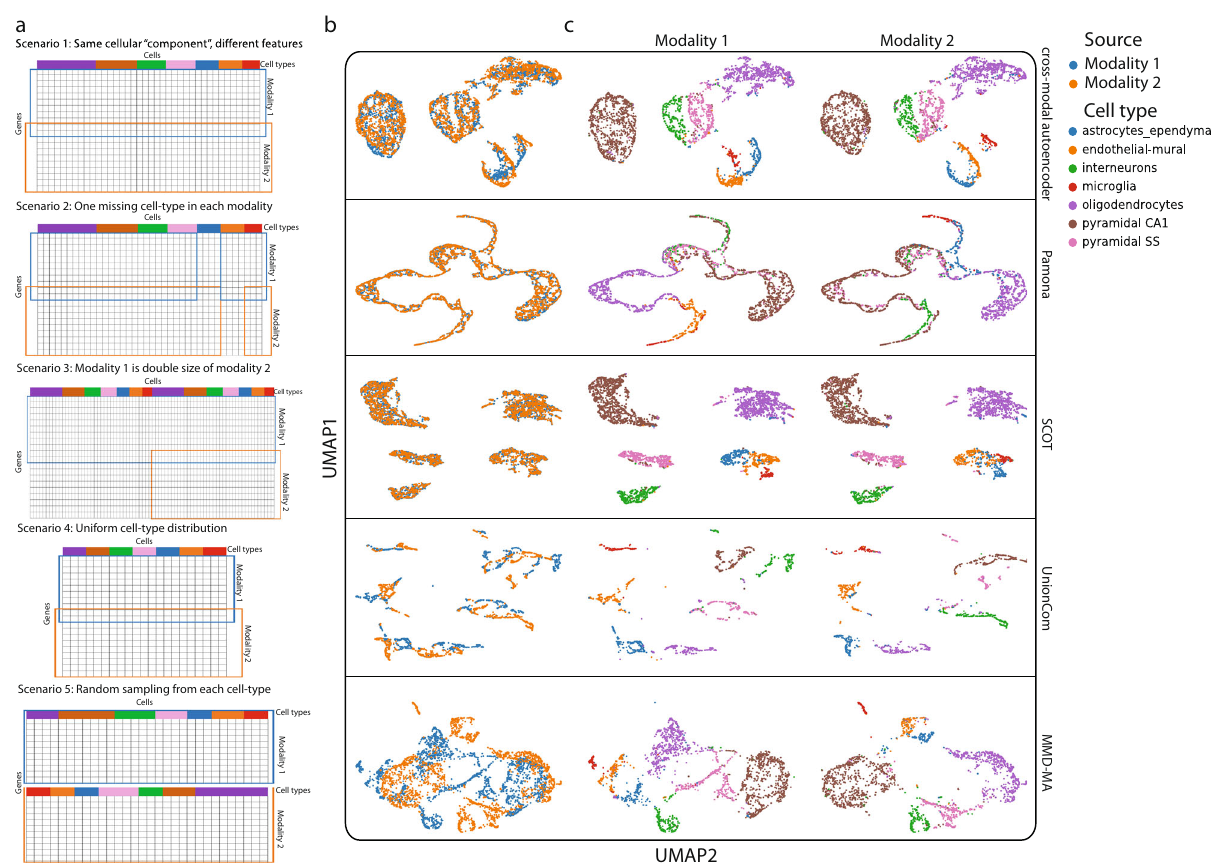
Fig. 1 Diagonal integration errors in fi ve scenarios. a Five scenarios of simulated multimodal single-cell data, showing how each modality was generated. b and c Visualization of integration by selected diagonal methods. Cells are colored by modality ( b ) and cell type identity ( c ). The two modalities are split into separate visualizations in c to make arti fi cial alignment errors visible. SCIM is not demonstrated due to overall poor representation learning. Alignment outcomes of all fi ve scenarios by each method are shown in Supplementary Figs. 1 –